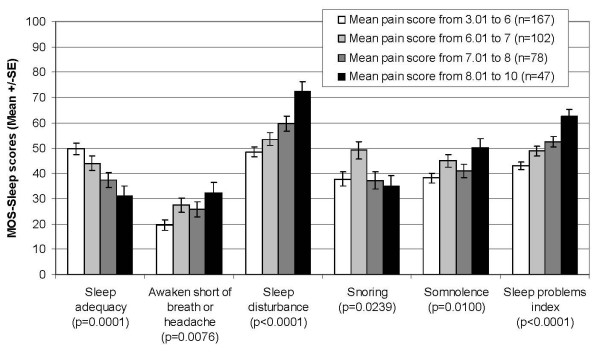
MOS-Sleep scores according to the mean pain score at baseline; SE: Standard Error; p: Kruskal-Wallis p-value for between-group comparison.